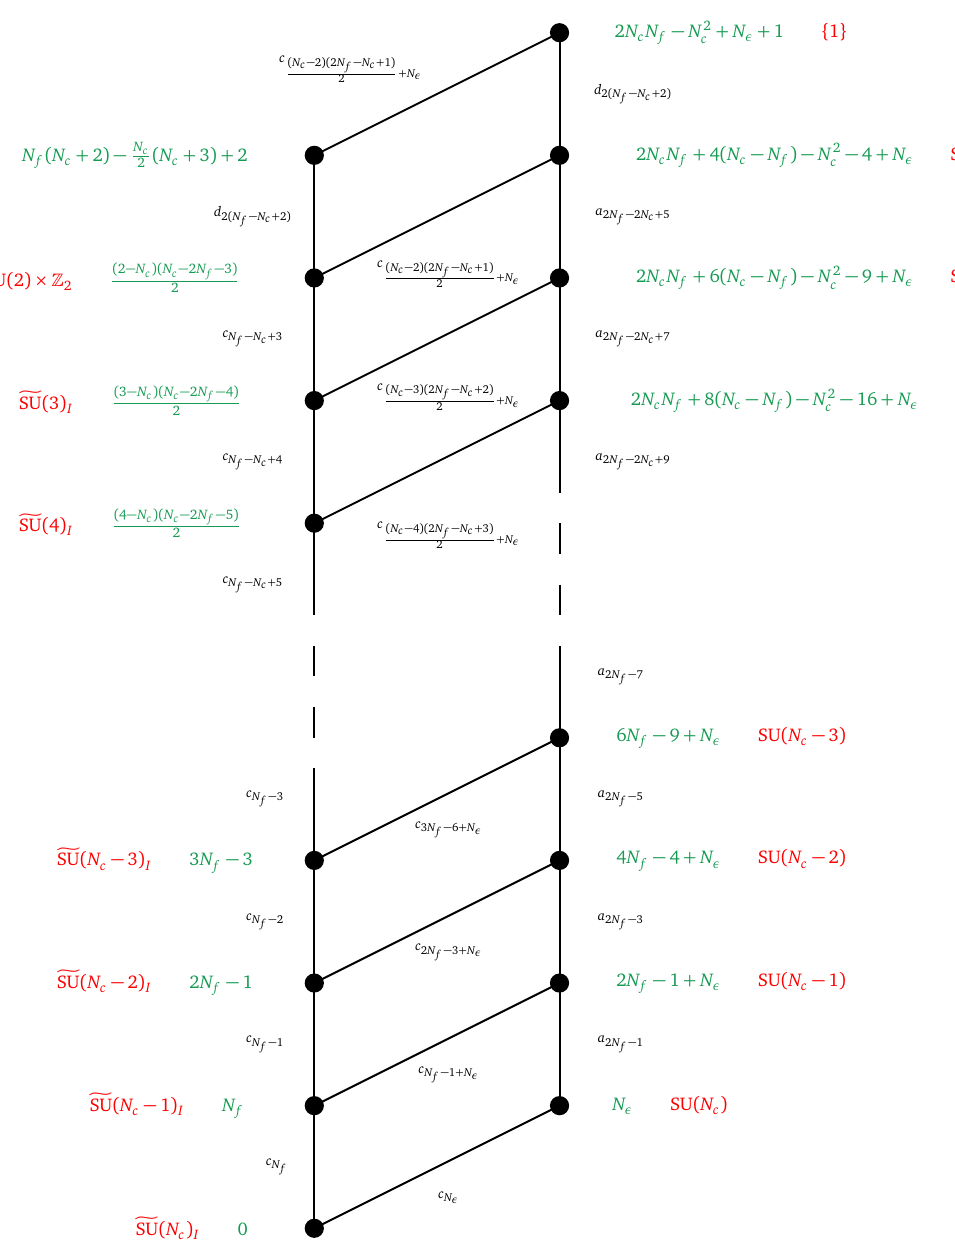
) + N ( F ⊕ F ) + N ε for N ≥ N . ε c I f f c